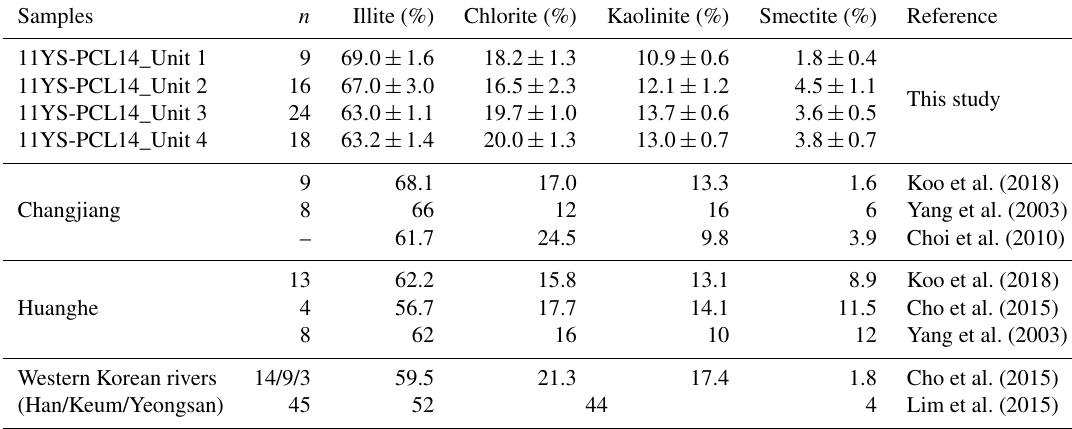
Table 2. Average compositions of clay minerals in core 11YS-PCL14 sediments and their potential provenance rivers. Samples